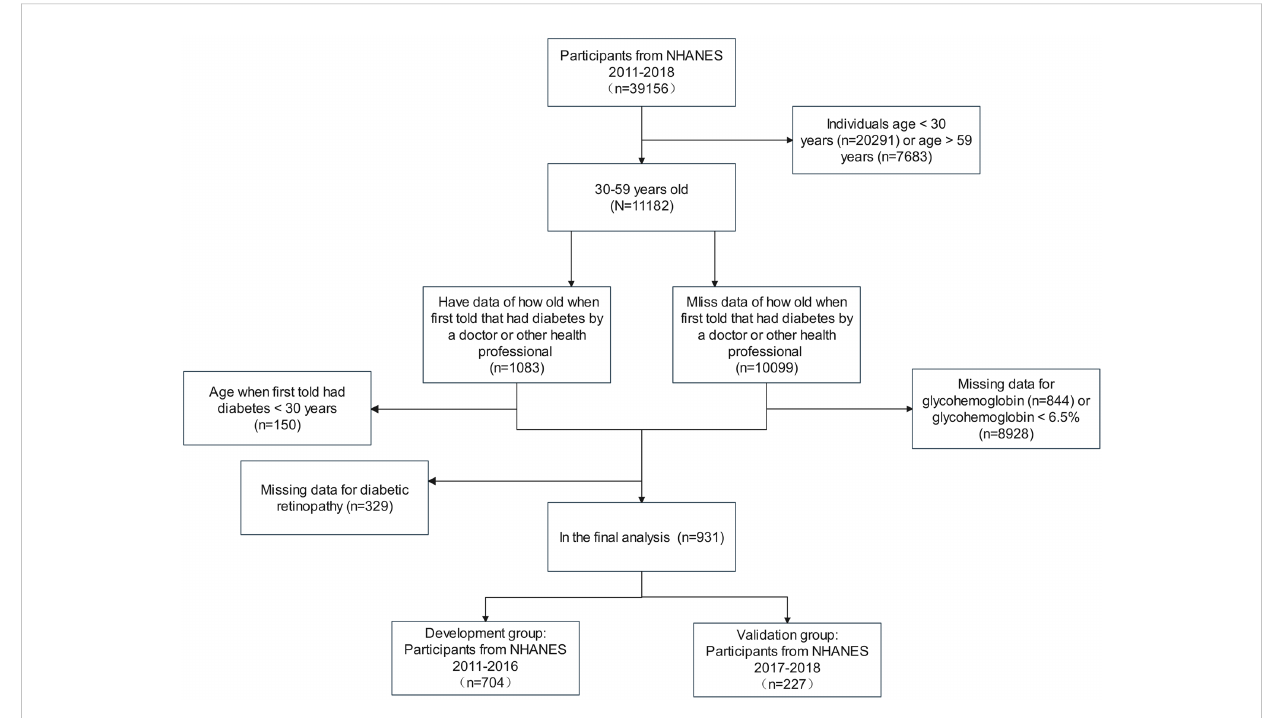
FIGURE 1 Flow chart of the development and validation